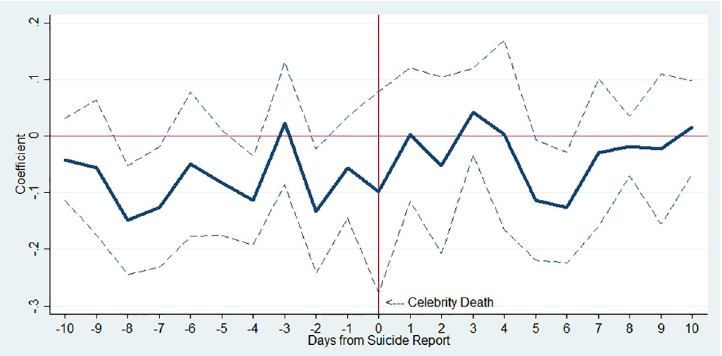
Fig 9. Estimated changes in total suicides before and after media reports on celebrity who died from accidents or illness, not suicide. Note: The y -axis indicates an approximate percent change in public suicide by corresponding day, which is the estimated β in Eq (1). The dotted lines indicate 95% confidence interval. k